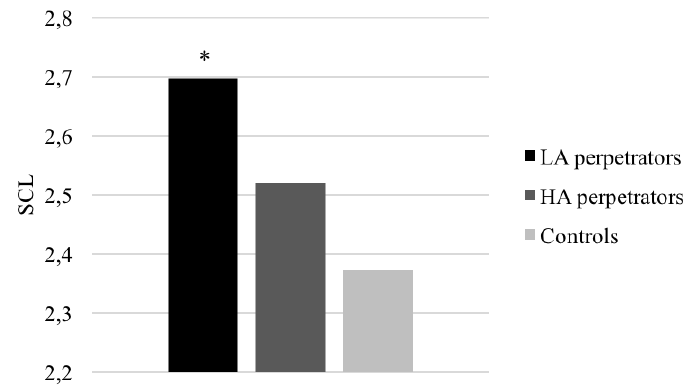
Figure 2. Skin conductance level (SCL) average in response to acute stress for IPV perpetrators (with different levels of alcohol consumption) and controls (* p < 0.05).